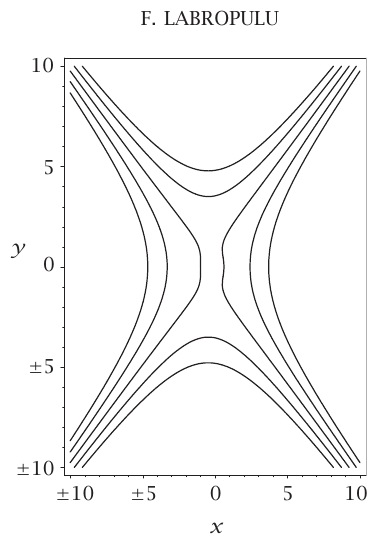
Figure 3.2 . Streamline pattern for x 2 − y 2 + x + ln (x 2 + y 2 ) = constant.